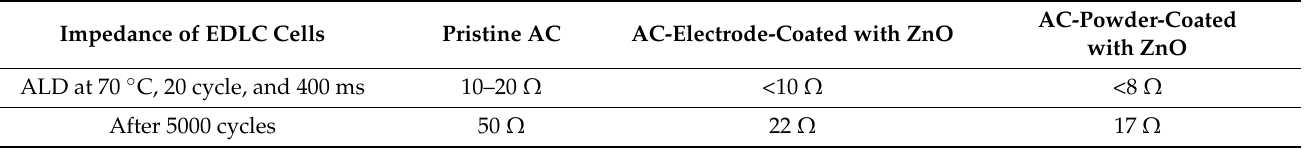
Table 2. Impedance comparison among various AC electrode materials.